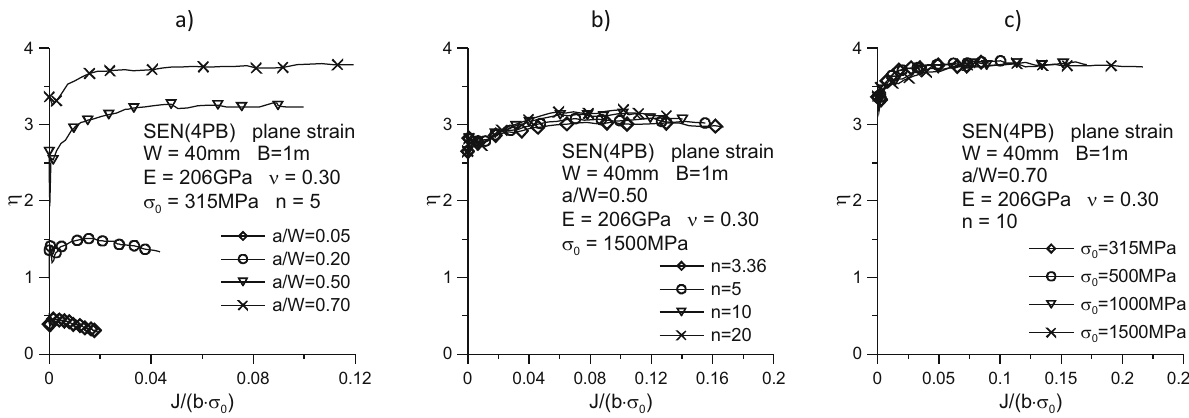
Figure 15: In fl uence of the relative crack length a / W ( a ) , the strain hardening exponent n ( b ) , and the yield point σ 0 ( c ) on the change of the η coe ffi cient for SEN ( 4PB ) specimens as a function of the increasing external load, expressed by J integral, normalized by the product of the length noncracked section of the specimen and the yield point – the η = f ( J / ( b · σ 0 ))